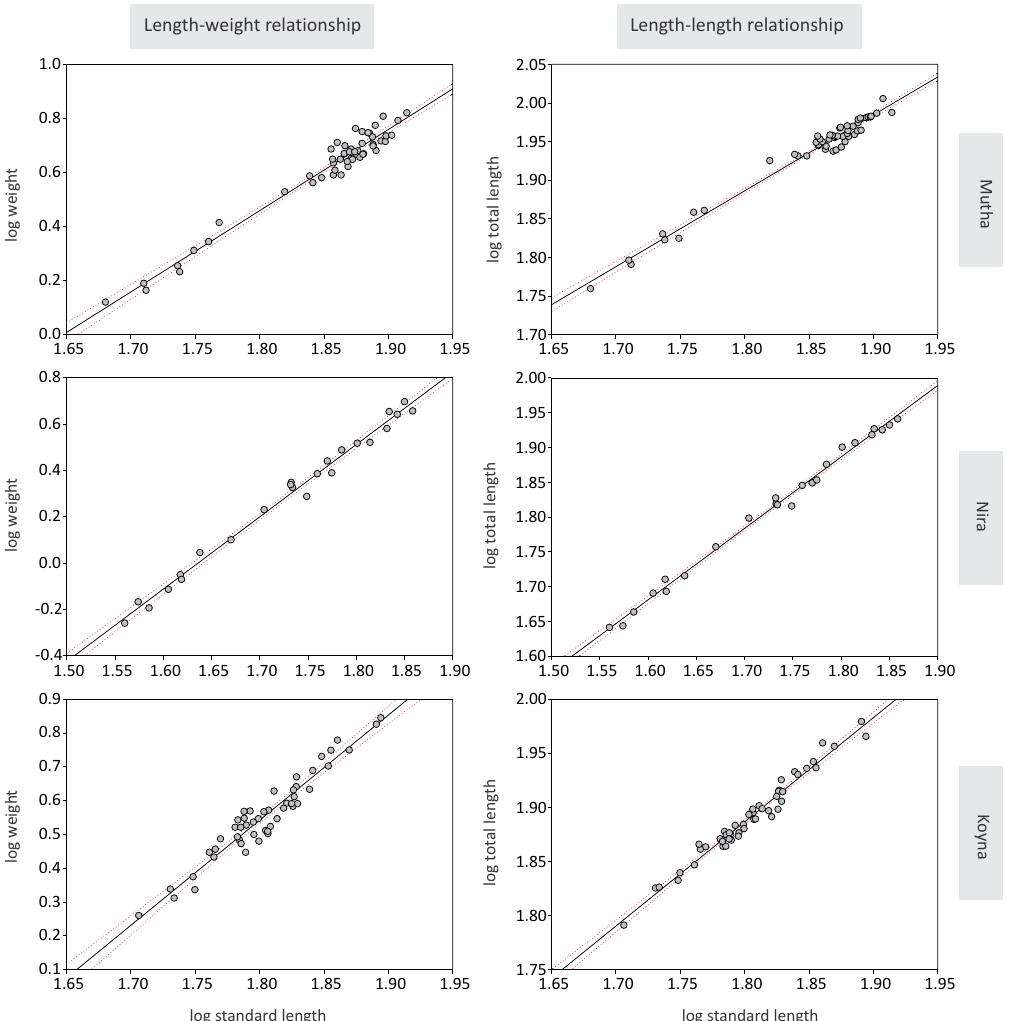
Appendix F. Scatter plots for Nemachilichthys rueppelli . Dashed lines are 95% confidence intervals for the regression